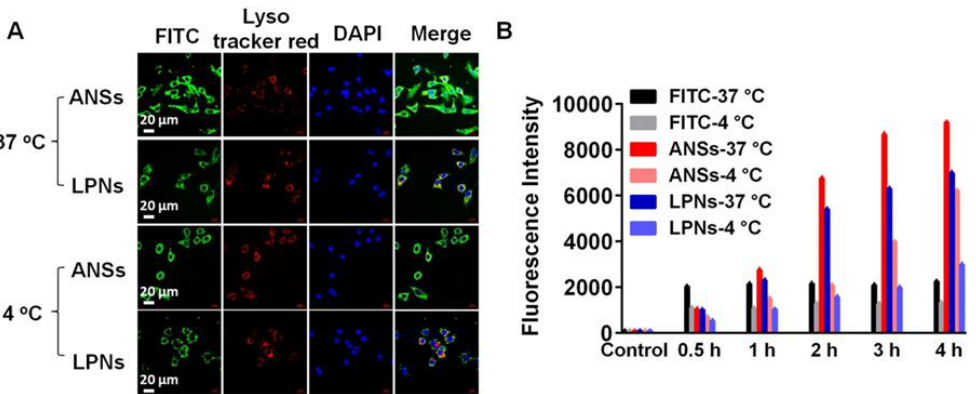
Figure 5. ( A ) Comparison of cellular uptake of FITC-labelled complexes of ANSs (FITC–ANSs) and FITC-labelled LPNs (FITC–LPNs) at 37 °C and 4 °C in A549 cells after 4 h incubation at a FITC concentration of 2.5 µg/mL. ( B ) Quantification of cellular uptake assayed by flow cytometry ( n = 5).